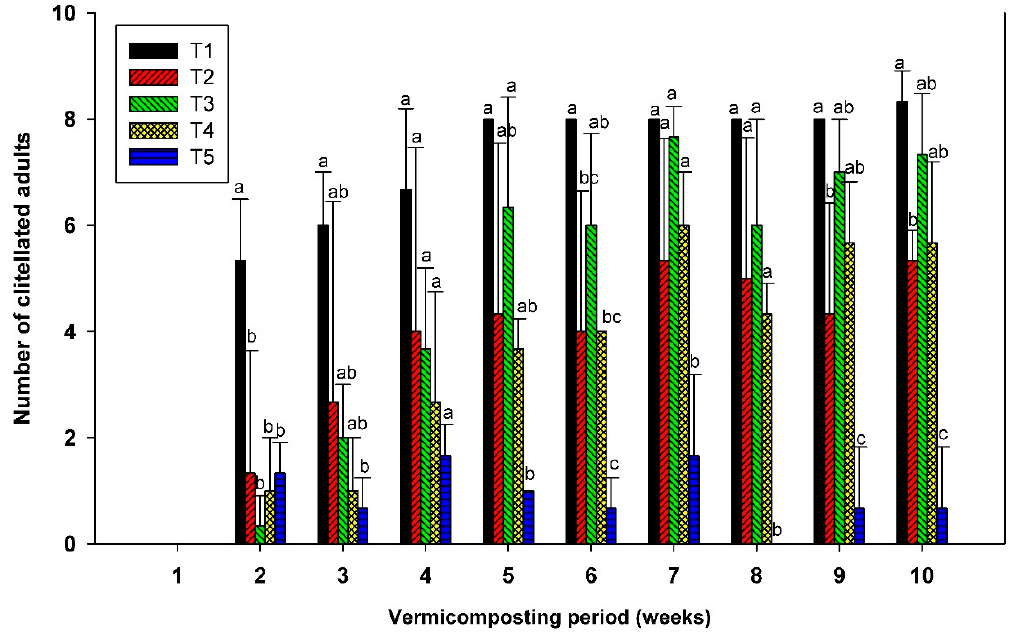
Figure 5. Mean ± SD values of the number of clitellated earthworms followed by different letters in the same week are different in terms of statistical significance ( p -value < 0.05) between the combinations involved.